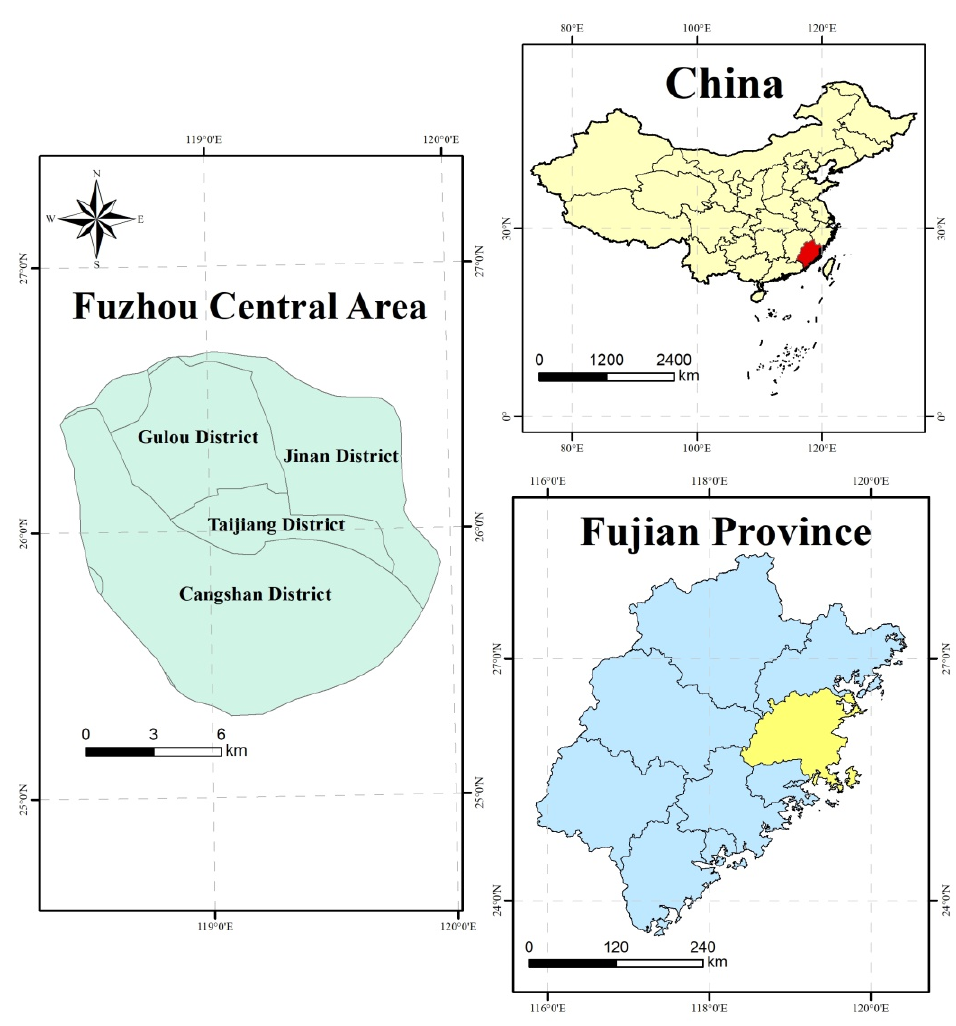
Figure 1. The location of the study area: Fuzhou central area, China.